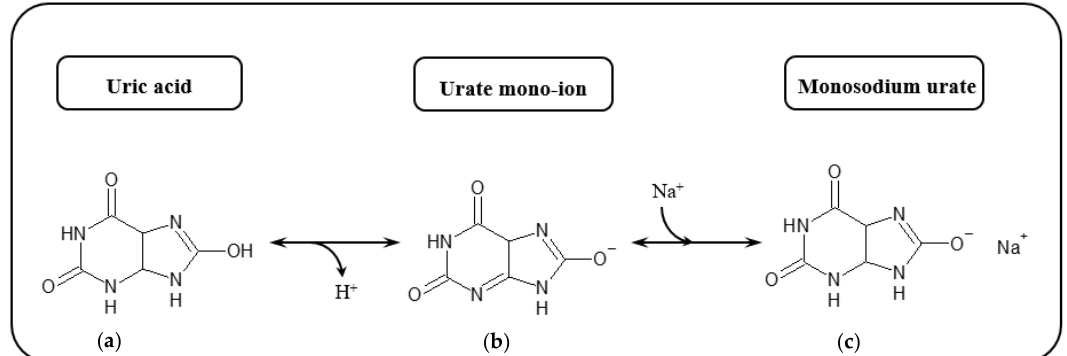
Figure 12. The various chemical structures of uric acid in the physiological medium. ( a ) UA structure after purine breakdown (illustration of UA keto tautomer; ( b ) under physiological pH of 7.4 and 37 °C, UA predominately exists in the form of deprotonated monoionic urate; ( c ) owing to sodium significant concentration and ionic strength, urate ions are disposed to precipitate as monosodium urate salt.